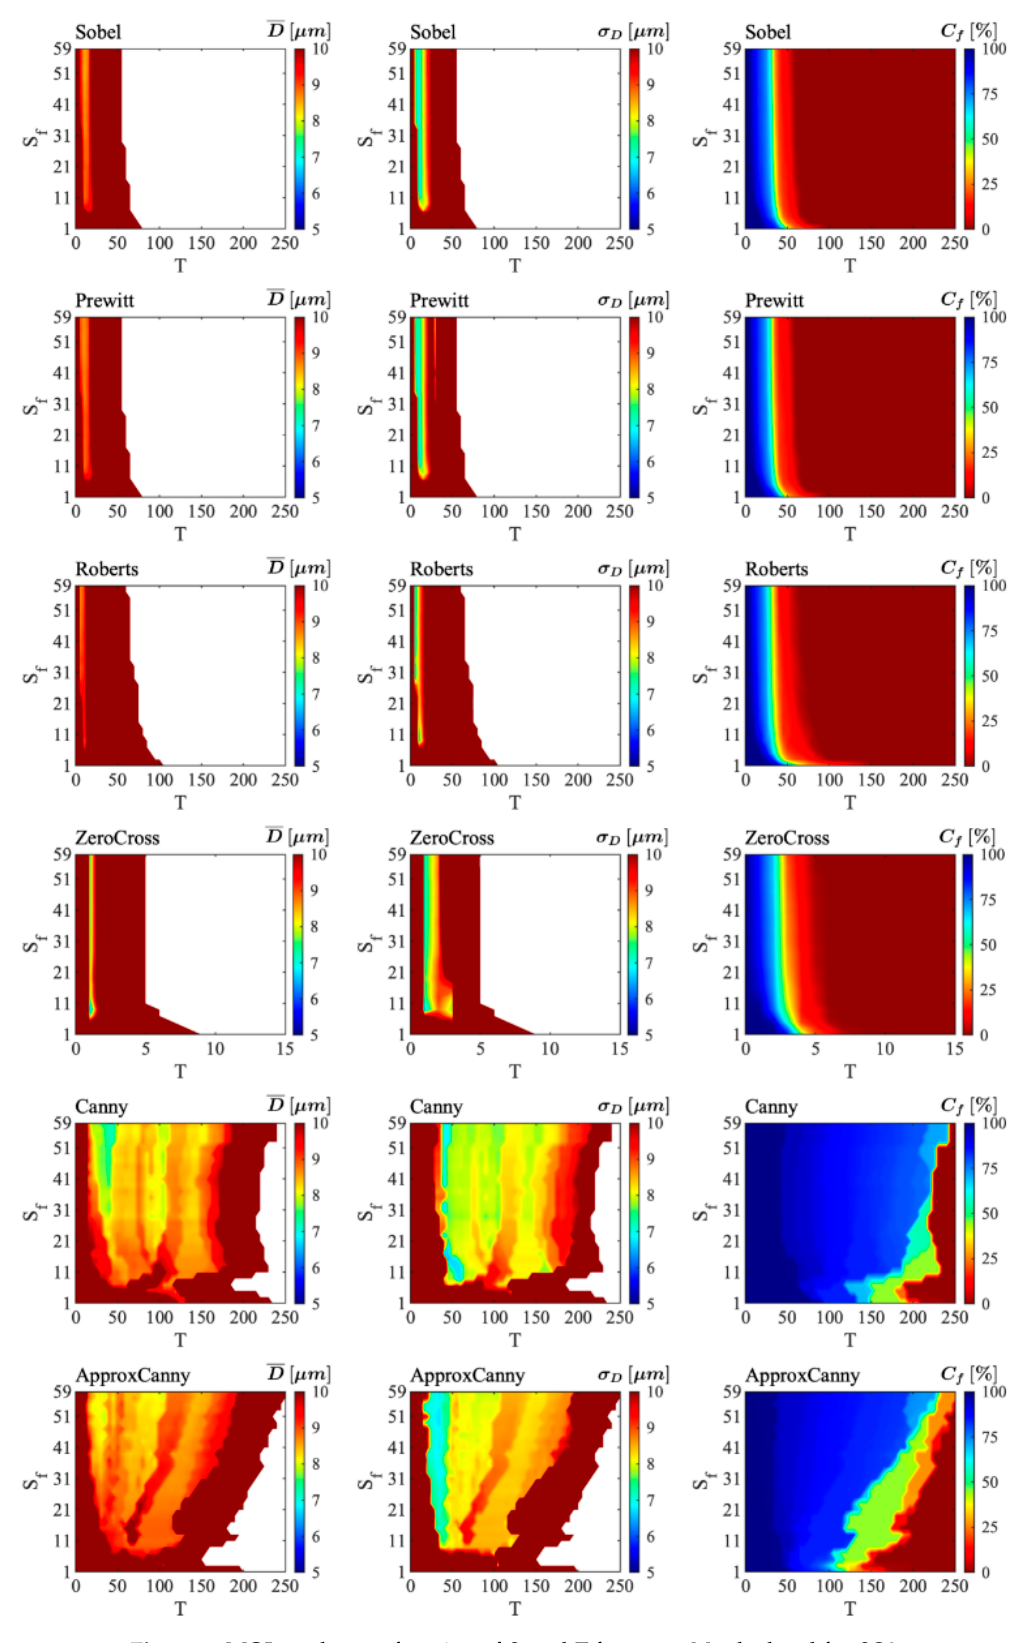
and 𝑇 for every 𝑀 calculated for 𝑆𝑂2 . (cid:3033)